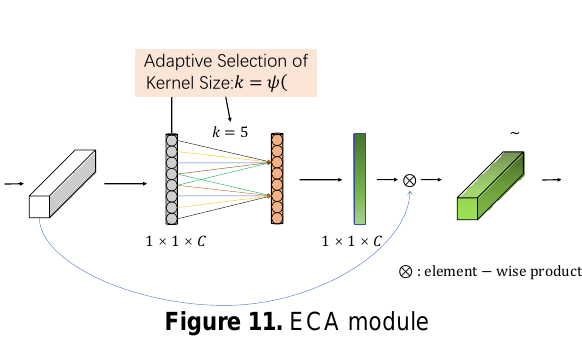
Figure 10. Structure of ECA module